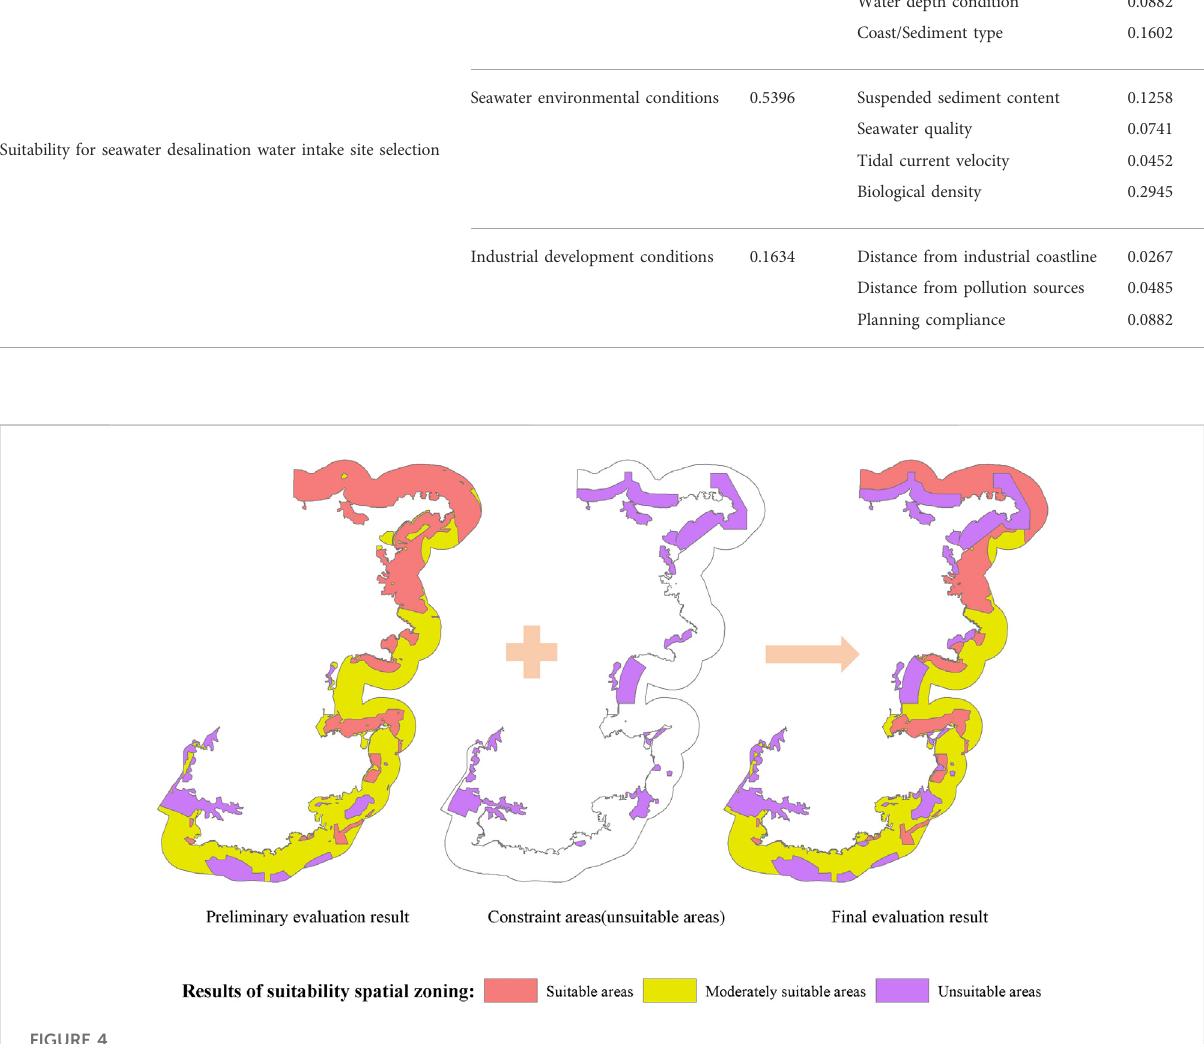
FIGURE 4 The results of suitability spatial